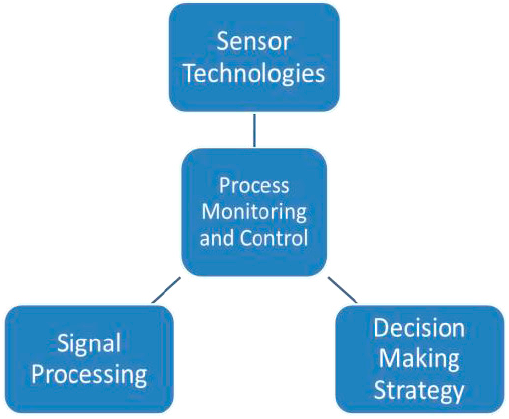
Figure 1. Building blocks of machining process monitoring (indirect).